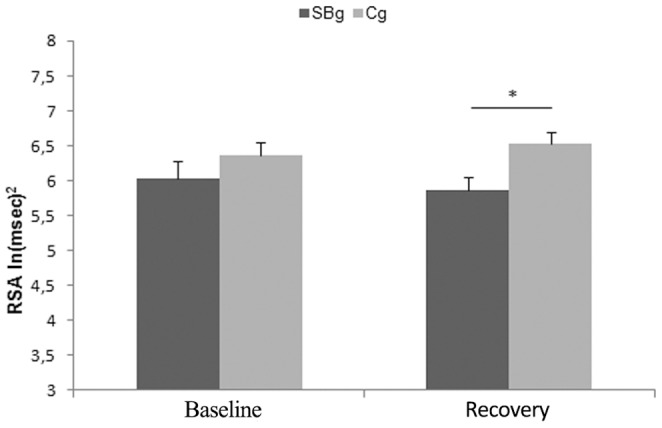
Baseline RSA values.Baseline and Recovery RSA values for Street-Boys group (SBg) and Control group (Cg). * = p<0.012. Error bars are SE.